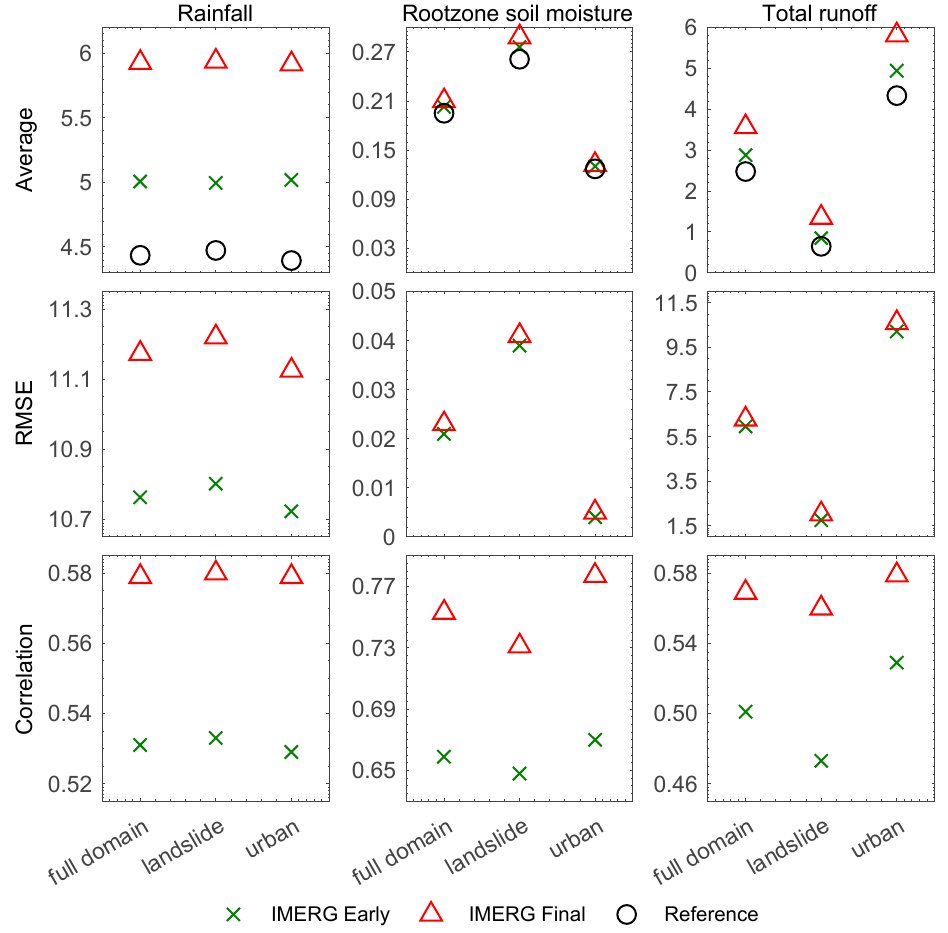
Figure 6. Average, RMSE and correlation of precipitation, rootzone soil moisture and total runoff derived from experiments using ground-based, IMERG Early and IMERG Final precipitation estimates. Results are shown as medians for 2001–2019 wet seasons over the full domain, and landslide-prone and urban areas. Average and RMSE units are mm/day for rainfall and total runoff, and m 3 /m 3 for rootzone soil moisture.